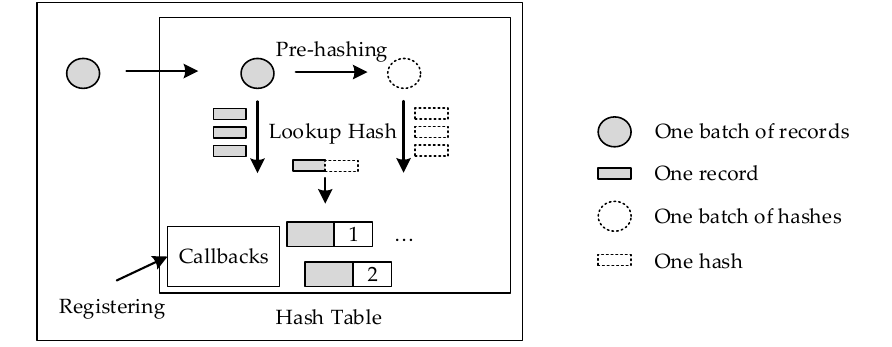
Figure 8. Aggregator using a hash table with vectorized programming interface and